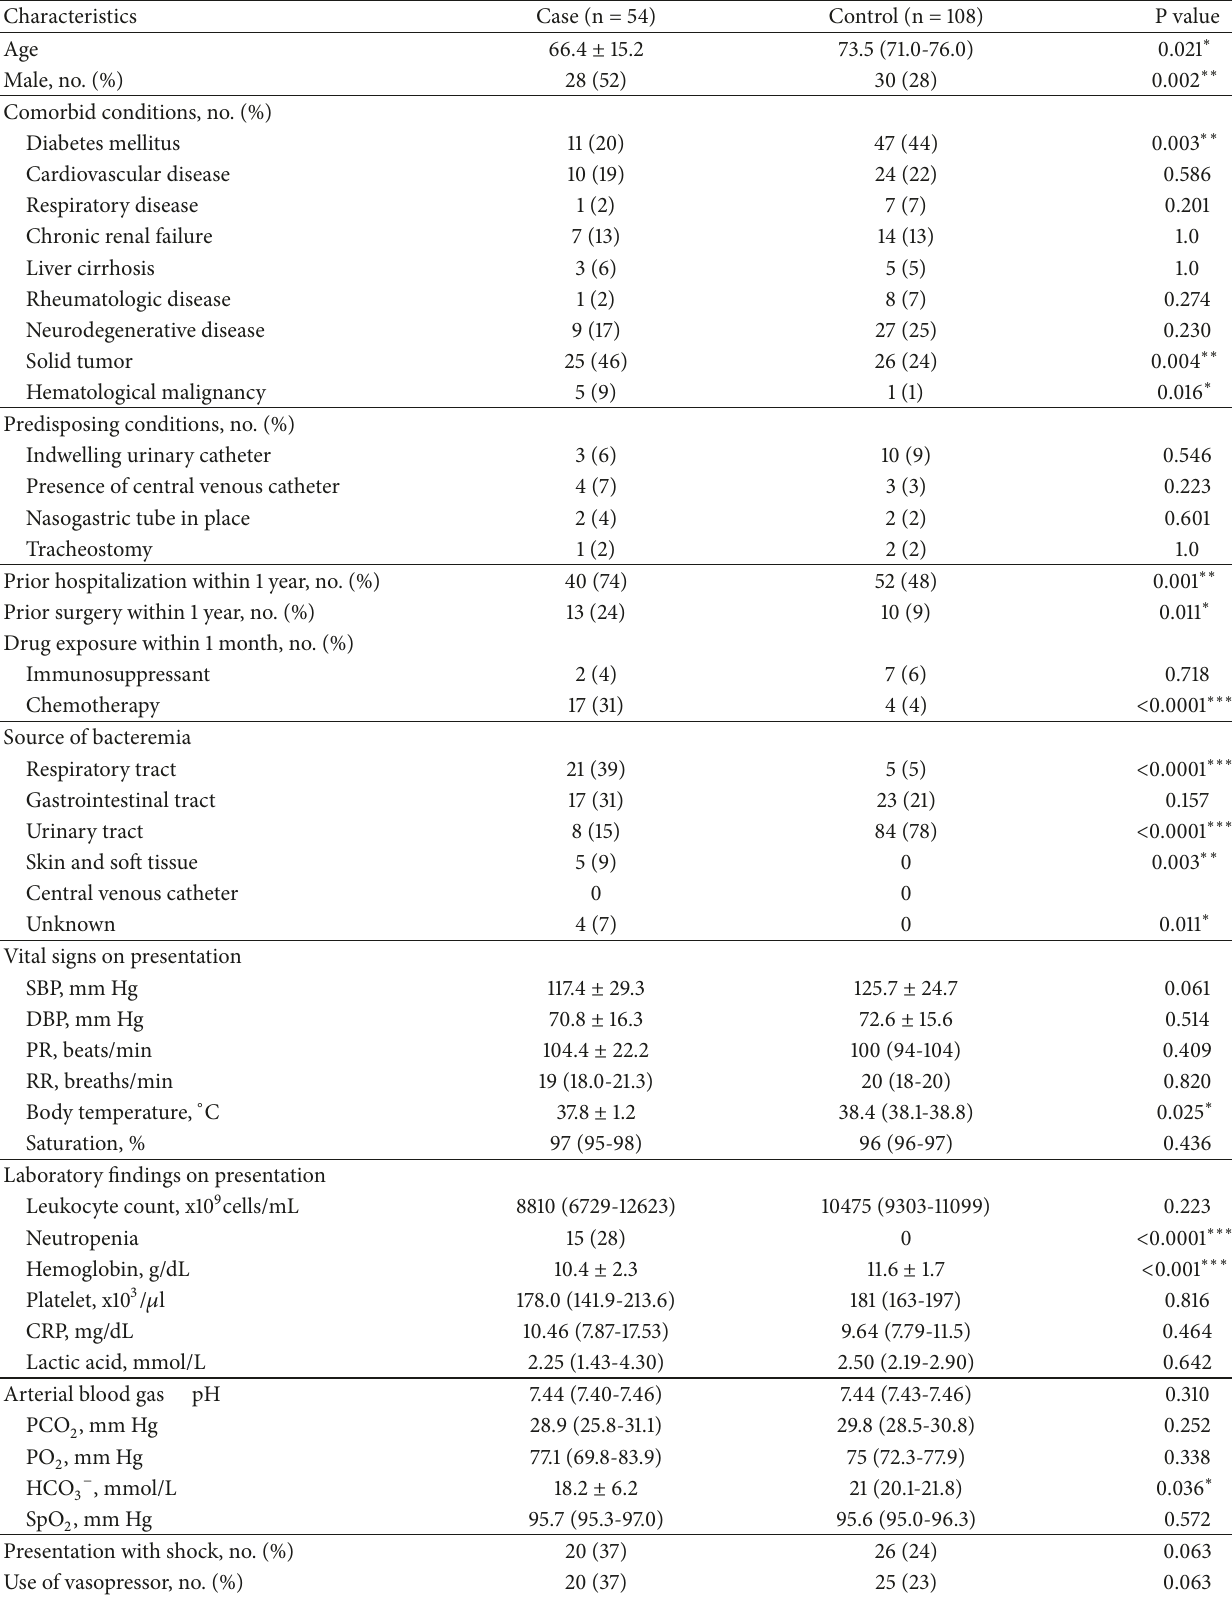
Table 1: Comparison of clinical characteristics of 54 case patients with Pseudomonas bacteremia and of 108 control patients with E. coli bacteremia in the